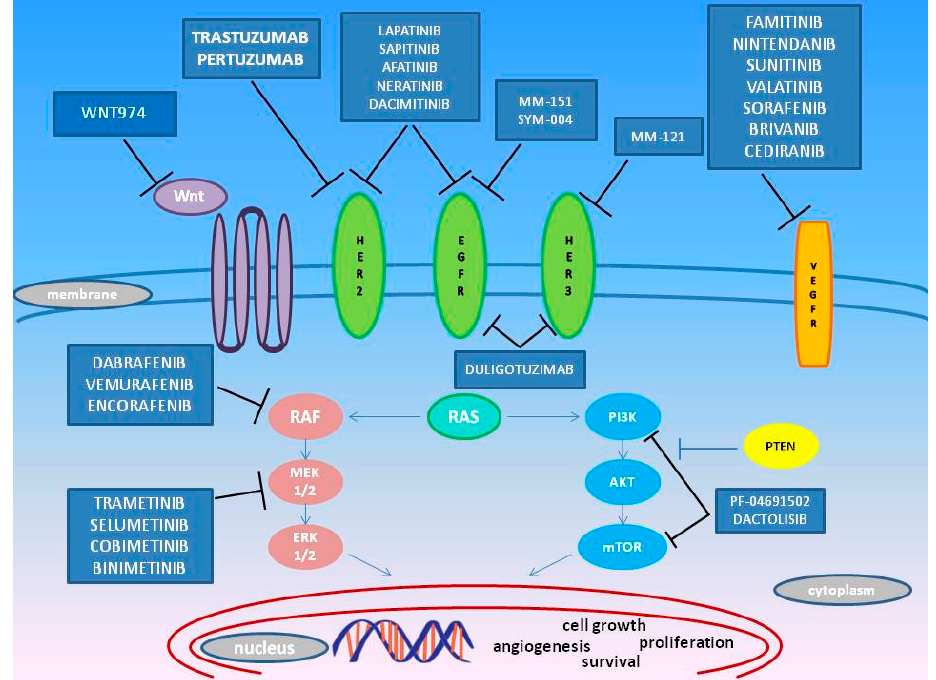
Figure 2. Molecular targets of recently developed agents (T arrows) designed to target additional deregulated pathways (blue arrows) in CRC (i.e., MEK/Akt, HER-2, HER-3, PI3K-mTOR, and BRAF). 3.1. HER